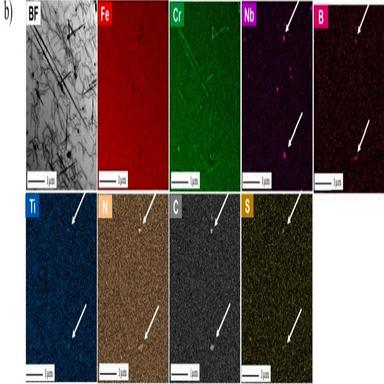
a) Panoramatic TEM images and b) Chemical Maps shows Stacking Fault after creep test of Alloy 709 under 150 MPa at 700 ◦C enriched in chromium according to Chemistem. White arrows pointing to some precipitates enriched in Nb, B, Ti, N, C, and S.